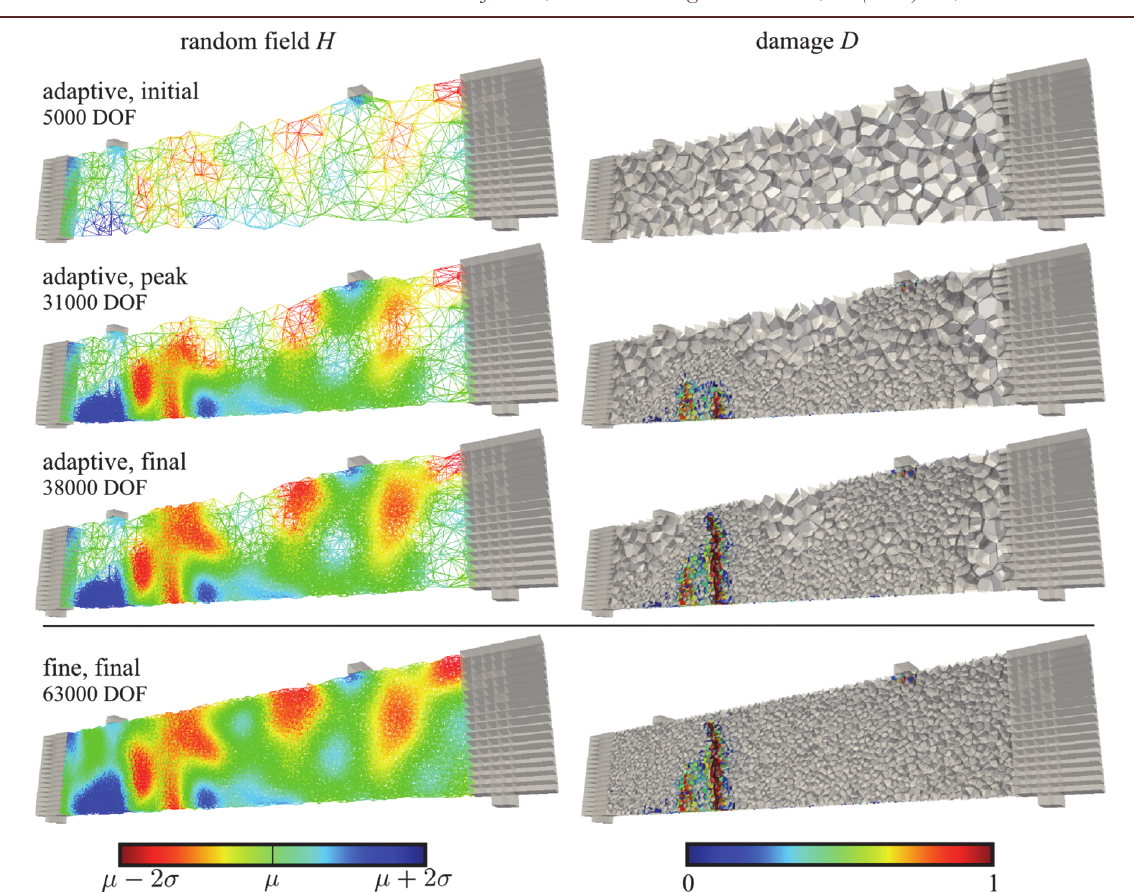
Figure 4: Damage patterns and random field discretizations developed during the simulation of four-point bending test for the adaptive and fine